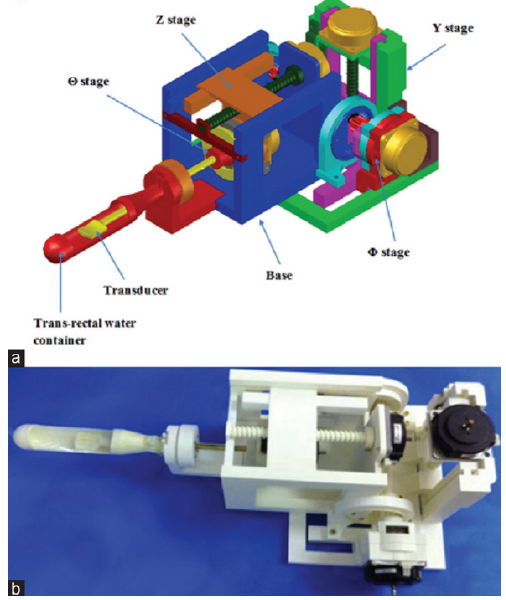
Figure 16. ( a ) CAD drawing of Giannakou et al.’s system for prostate cancer [76]. ( b ) Physical system with four computer-controlled